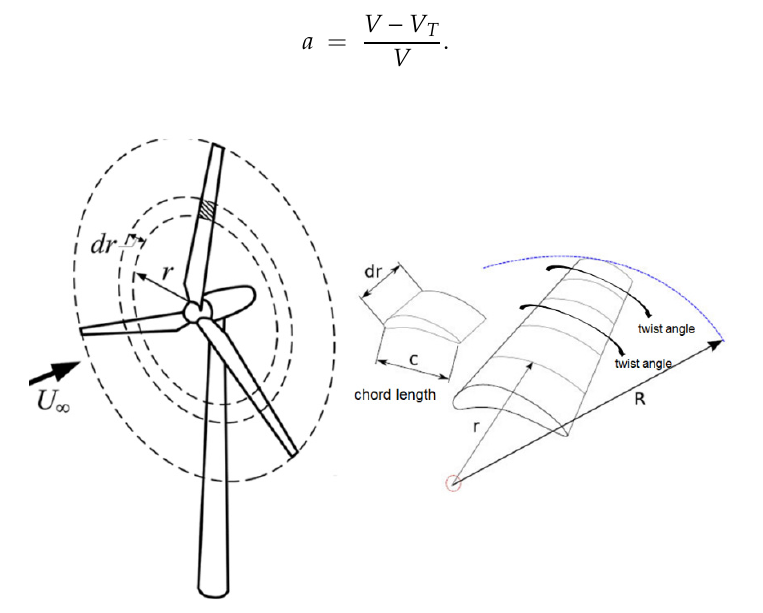
Figure 1. Schematics of the blade elements.